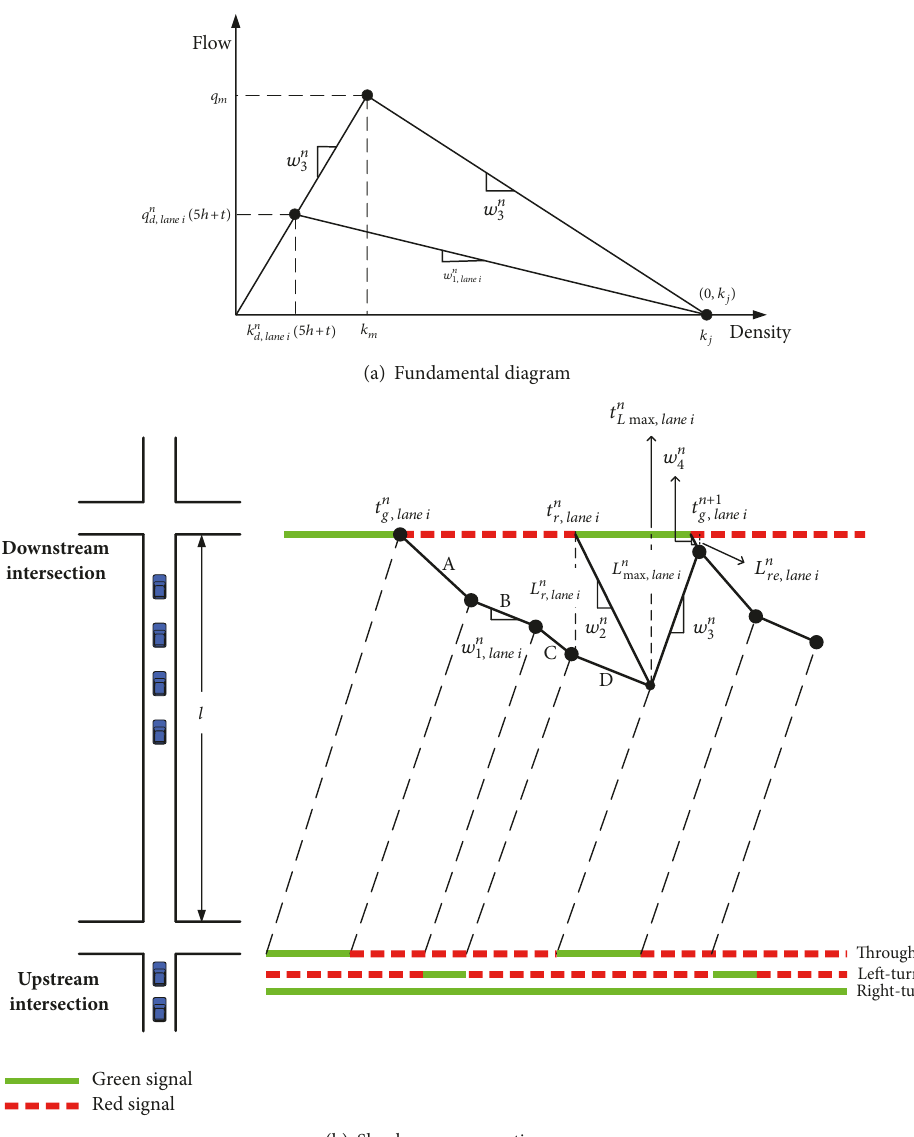
Figure 1: (a) Fundamental diagram; (b) shockwave propagation